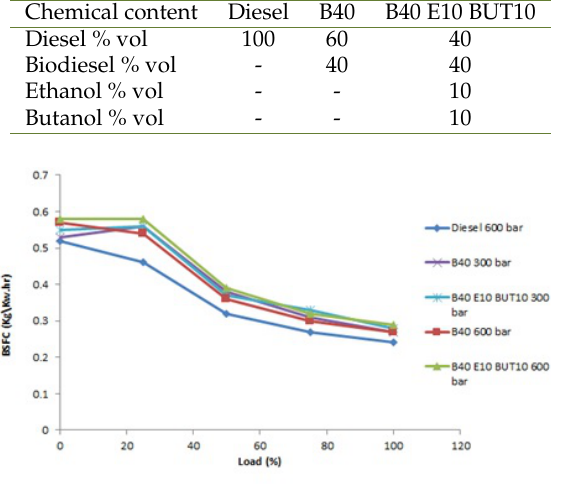
Fig. 2. Various BSFC with Engine